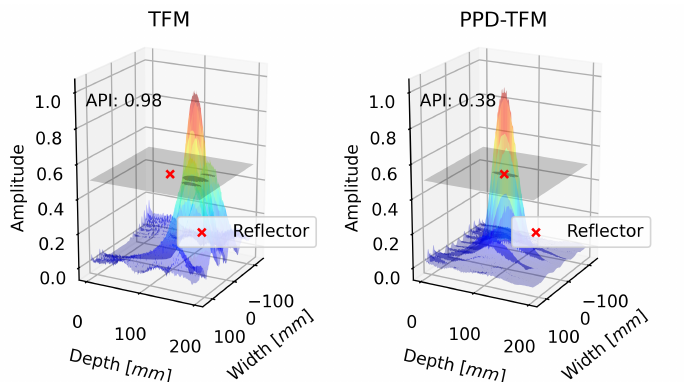
Figure 6. Array performance indicator (API) for Simulation by TFM ( left ) and PPD-TFM ( right ).